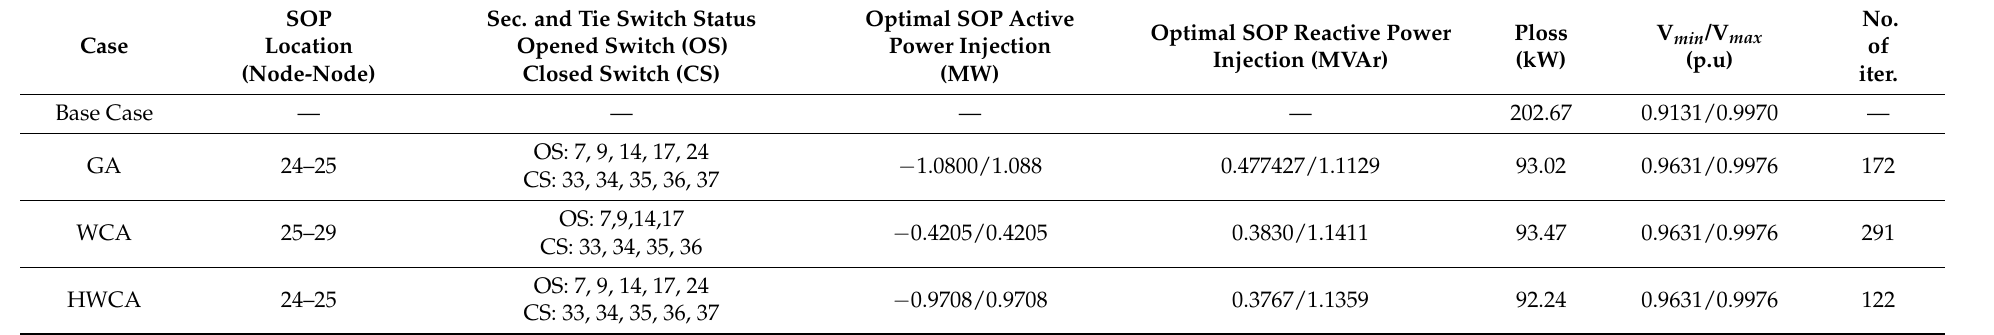
Table 3. Compared numerical results of HWCA for case 6 with WCA and GA for the 33-node system.